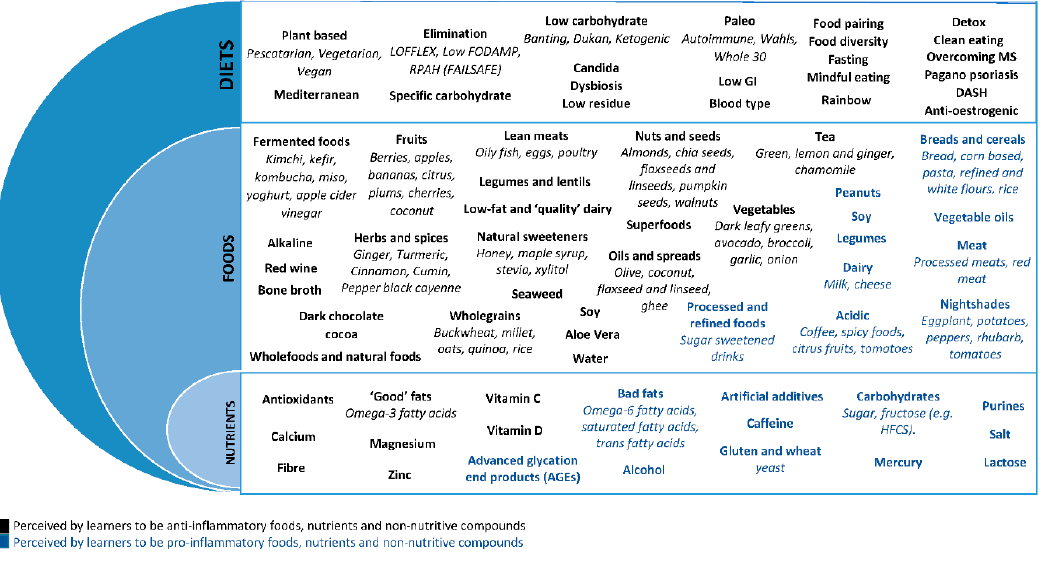
Figure 2. Summary of the diets, foods and nutrients reported by learners to affect